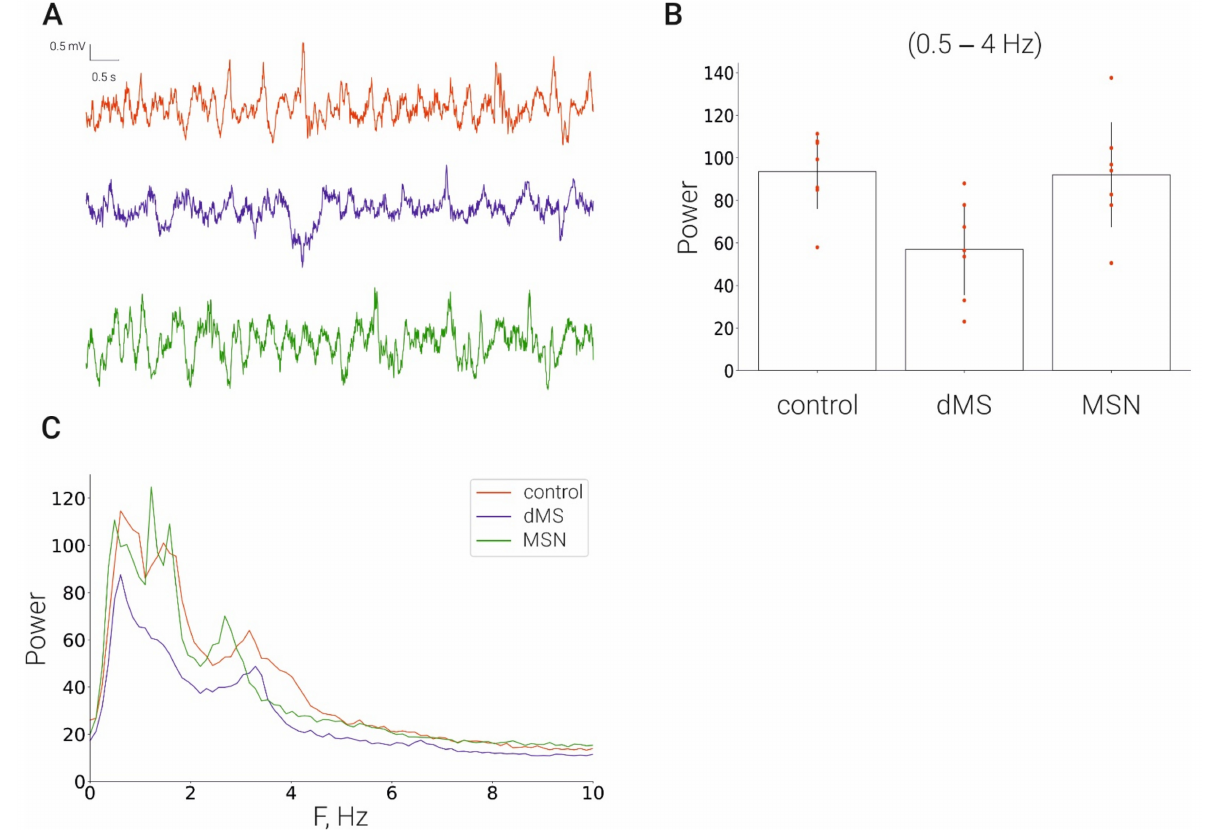
Figure 2. Effect of stimulation of the medial septum on the hippocampal EEG. ( A ), LFP time series of: control rats (red line), dMS rats (blue), MSN rats (green); ( B ), corresponding power spectra; ( C ), corresponding averaged power in frequency range [0.5–4]